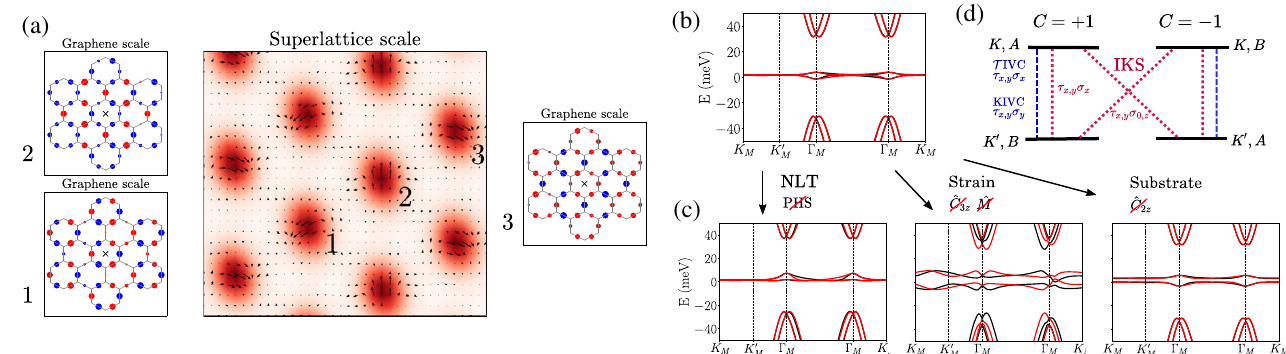
FIG. 1. (a) Real-space picture of an IKS state with q ¼ G 1 = 3 . The color plot on the superlattice scale shows the charge density, with dark spots corresponding to AA regions. Black arrows represent the complex IVC order parameter ∼ h τ x σ x i þ i h τ y σ x i . For each of the three inequivalent AA regions, the expectation value of c † A c B þ c † B c A on the microscopic graphene bonds is shown. Blue (red) dots correspond to positive (negative) expectation values, and the center of the AA region is marked with a black cross. The different ffiffiffi p ffiffiffi p 3 3 inequivalent AA regions have different approximate × Kekul´e-like patterns on the graphene scale. (b) The red (black) line shows BM band structure along a cut in the mBZ for valley K ( K 0 ). (c) The presence of nonlocal tunneling, strain, and substrate potential breaks various symmetries and affects the dispersion. (d) If these single-particle perturbations are weak, the interacting model has an approximate U ð 4 Þ C ¼ 1 × U ð 4 Þ C ¼ − 1 symmetry. Dashed and dotted lines indicate the channel of intervalley coherence that generically occurs for U ð 1 Þ V -breaking phases. τ x;y denotes any valley-off-diagonal components.